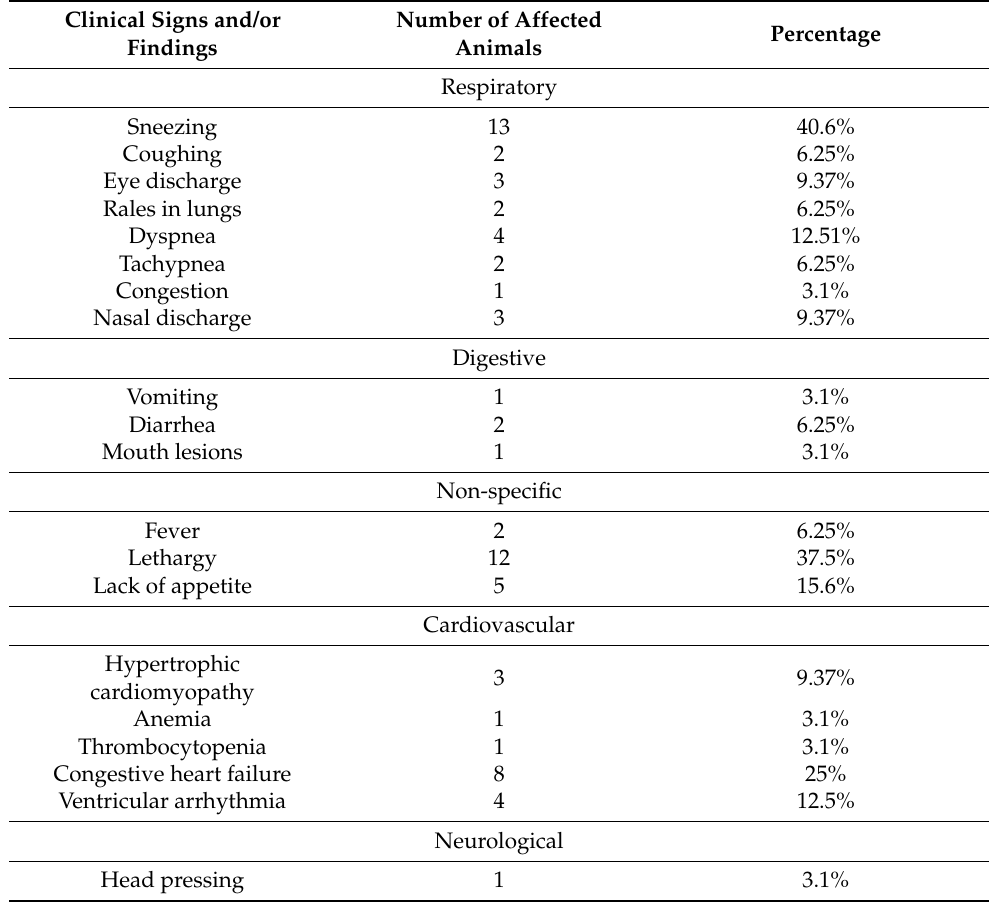
Table 1. Clinical signs reported in domestic cats diagnosed with SARS-CoV-2 infection [27,29,31,33–39]. Clinical Signs